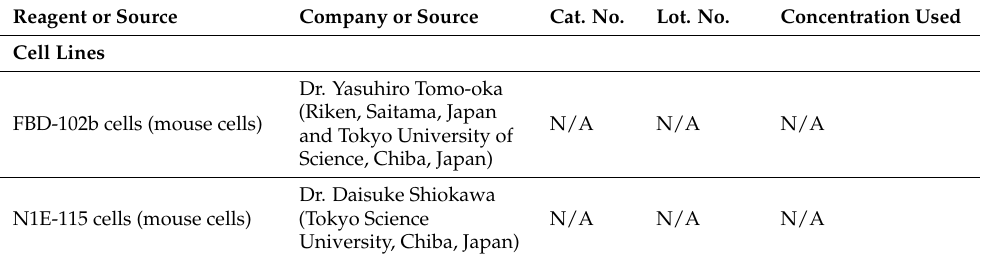
Table 4. List of cell lines.